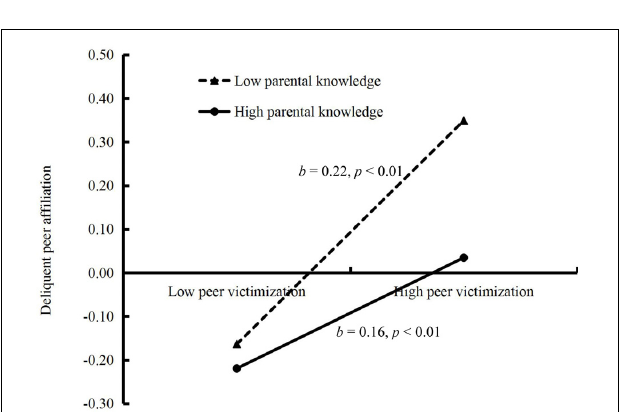
FIGURE 4 | Results from the test of simple slopes to assess the association between peer victimization and delinquent peer affiliation at high and low levels ( M ± SD ) of parental